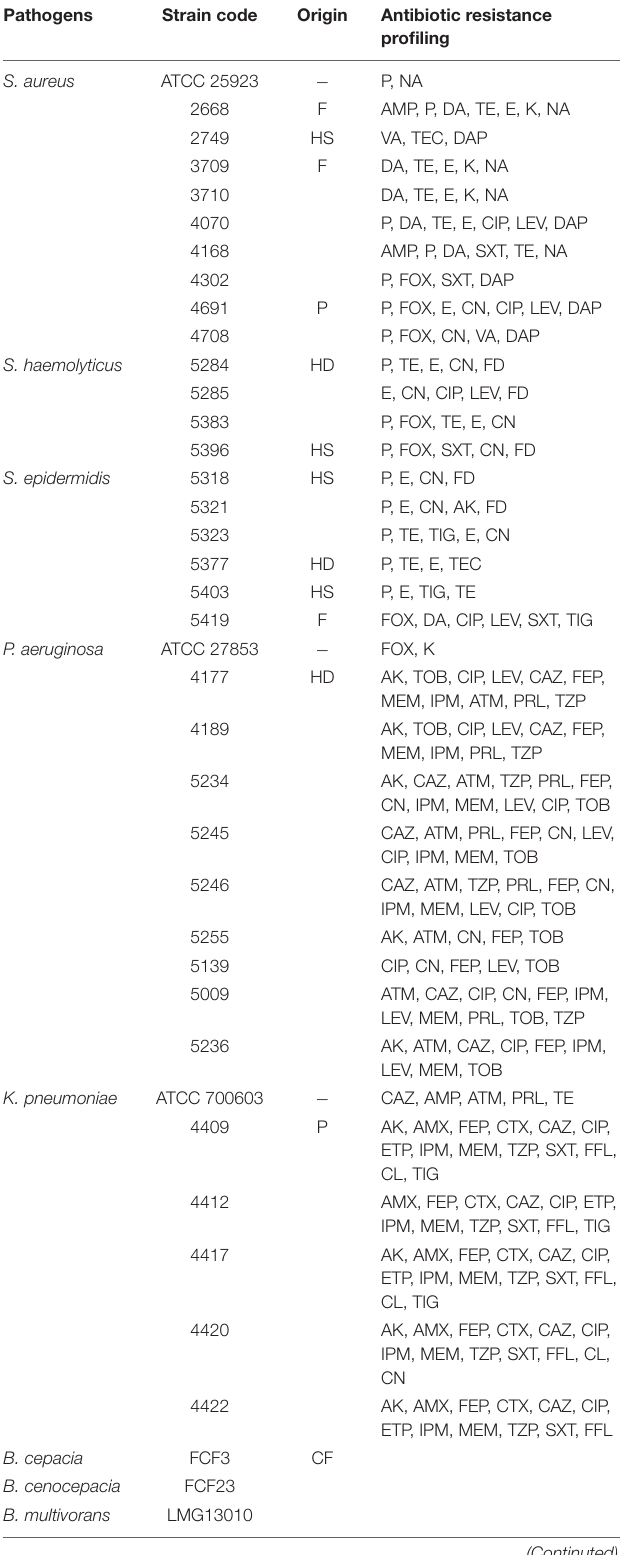
TABLE 3 | Pathogenic strains used in the study and related antibiotic resistance profiling. Pathogens Strain